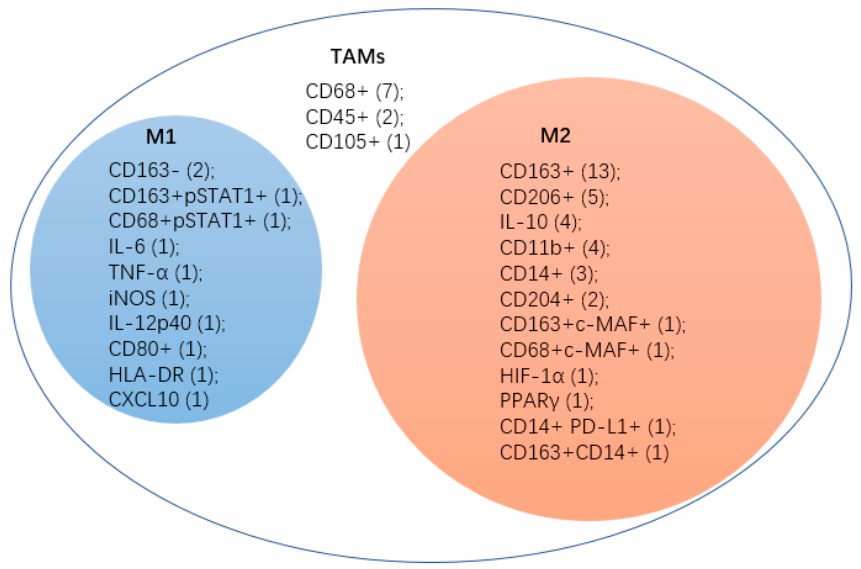
Figure 2. This figure shows the makers which were used in cervical cancer researches. M1, M1-like macrophages; M2, M2-like macrophages; TAMs, tumor-associated macrophages. The numbers in the parentheses represent the number of published parentheses represent the number of published papers.